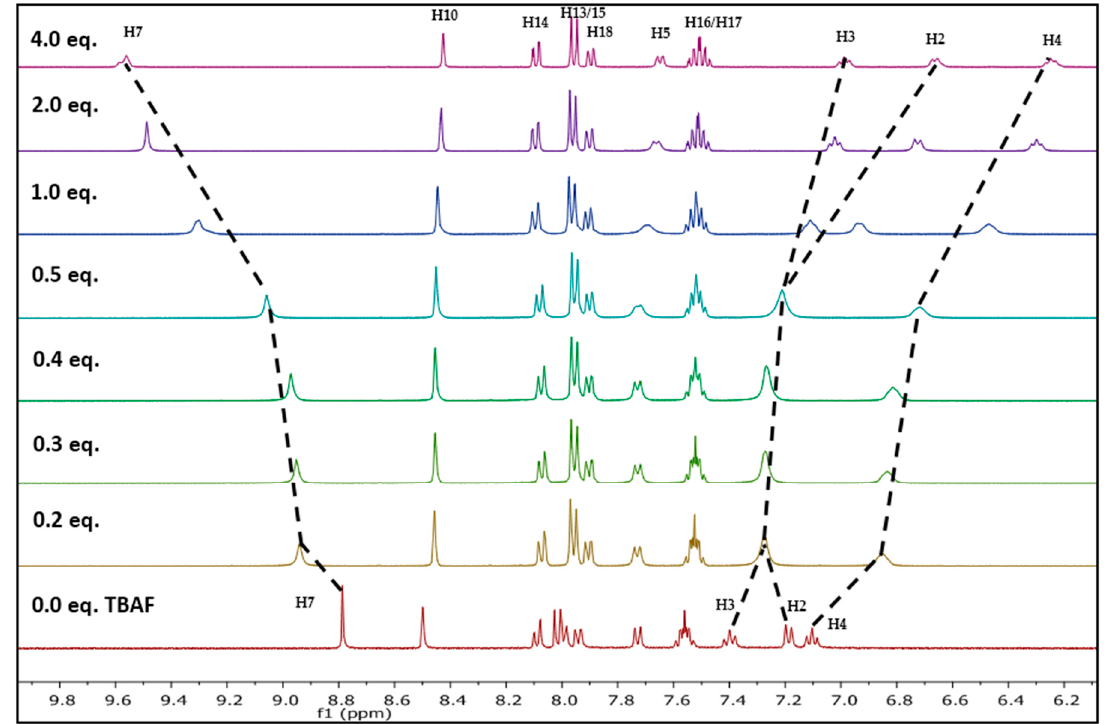
Figure 6. Changes in partial 1 H-NMR (400 MHz) spectra of NpTP (6.2 × 10 − 2 M) in CD 3 CN upon increasing equivalents of TBAF (0 to 4.0 eq.).